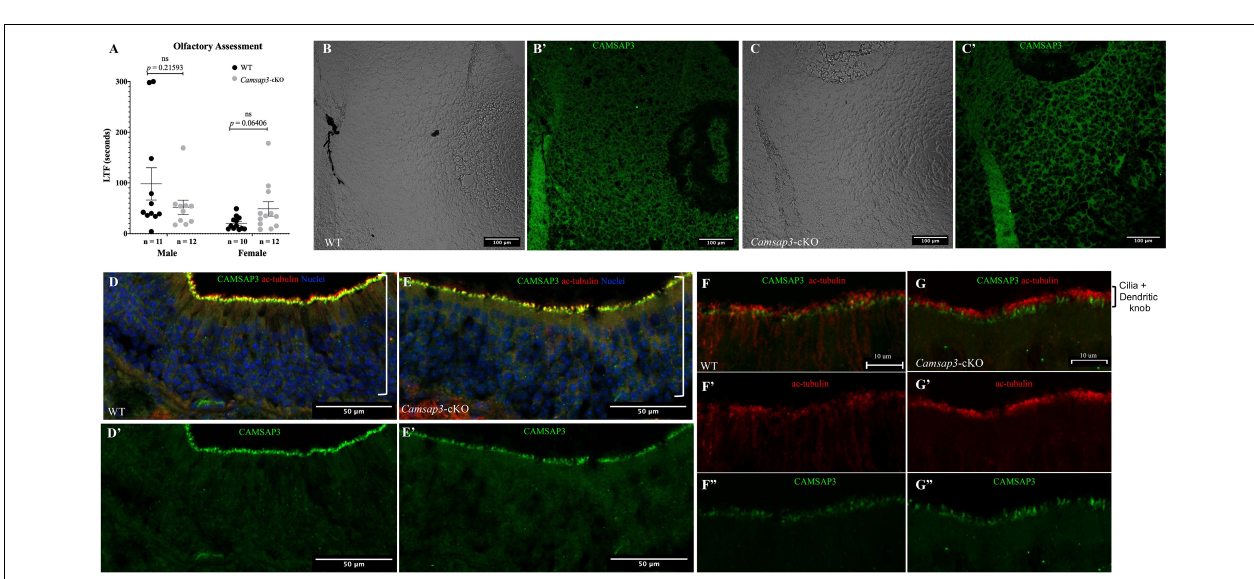
FIGURE 7 | WT and Camsap3 -cKO mice show no differences in olfaction. (A) No differences in the reaction time of the sense of smell between WT and Camsap3 -cKO mice. Bars represent mean ± SD. Unpaired t -tests revealed no significant (ns) differences between WT and Camsap3 -cKO mice in male or female mice. (B,C) CAMSAP3 had little expression in olfactory bulbs regardless of genotype, WT (B) or Camsap3 -cKO (C) . The representative images were taken from female WT and their Camsap3 -cKO littermates at P180. (B’,C’) were the cells shown in (B,C) stained with anti-Camsap3 (green). (D–G) CAMSAP3 was expressed in olfactory sensory neurons (OSN) in both WT and Camsap3 -cKO mice. Olfactory mucosa in the nasal cavity from WT (D,F) and Camsap3 -cKO (E,G) mice were stained with anti-Camsap3 (green), anti-acetylated tubulin (red, olfactory cilia, and nerve fibers), and Hoechst 33342 (blue, nuclei). (F,G) were images with higher magnification showing olfactory cilia and dendritic knobs layers on OSNs. (D’,E’,F”,G”) Showed the anti-CAMSAP3 (green) channel in (D–G) . (F’,G’) Showed anti-acetylated tubulin (red) channel in (F,G) . “[” Marks the OSN layer in the olfactory epithelium. Scale Bars = 100 µ m (B,C) , 50 µ m (D,E) , 10 µ m (F,G) .